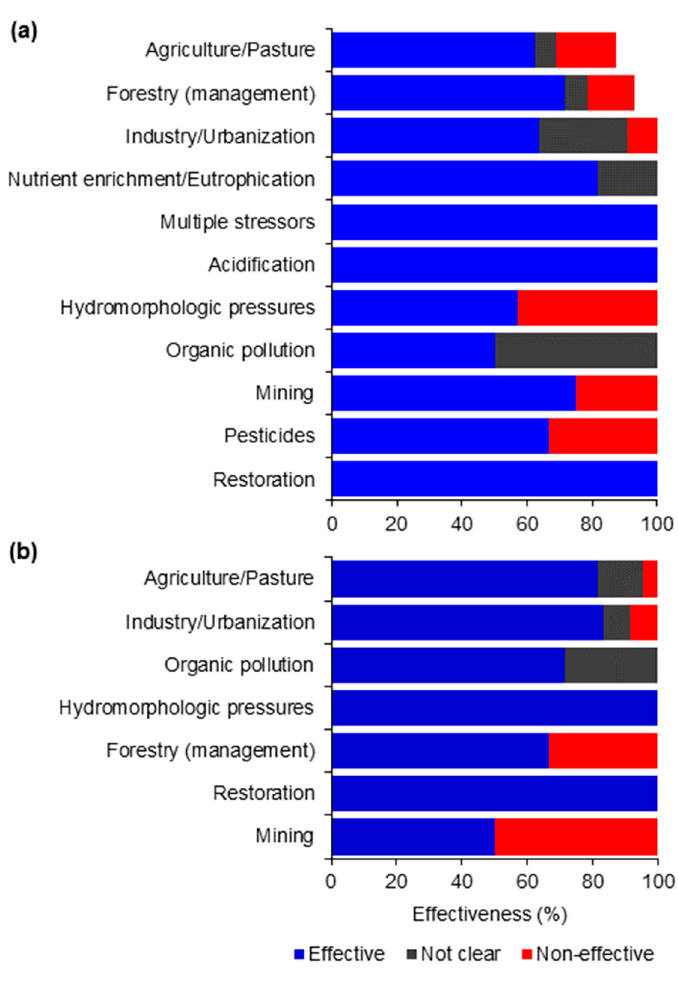
Figure 12. E ff ectiveness of the ( a ) organic matter decomposition and ( b ) ecosystem metabolism as bioassessment tools for each type of environmental change; only environmental changes addressed in ≥ 2 papers are shown. The first two types of environmental change in panel (a) do not reach 100% due to the absence of four field studies that did not discriminate the e ff ectiveness of organic matter decomposition from that of other functional indicators (Table S3). The types of environmental change are sorted by the number of papers in which they were addressed (see Figure 4).